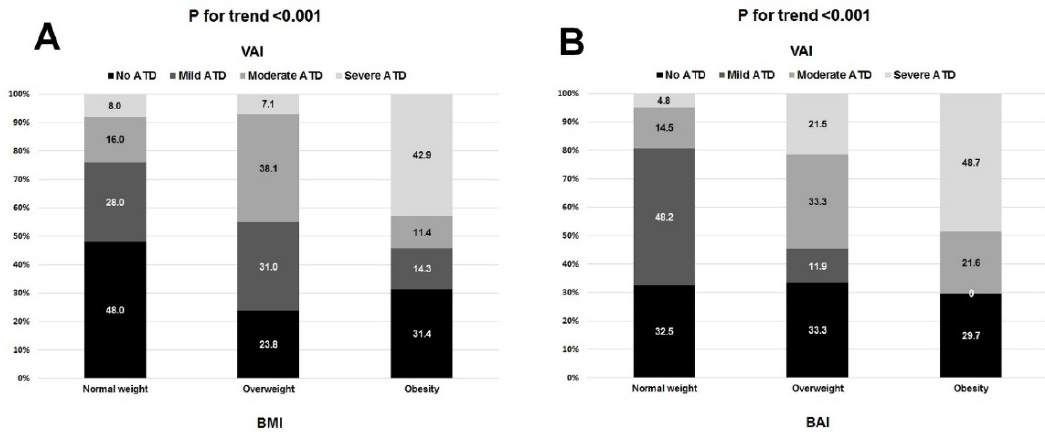
Figure 4. The distribution of VAI-defined adipose tissue dysfunction (ATD) types in respective BMI-defined ( A ) and BAI-defined ( B ) weight categories.